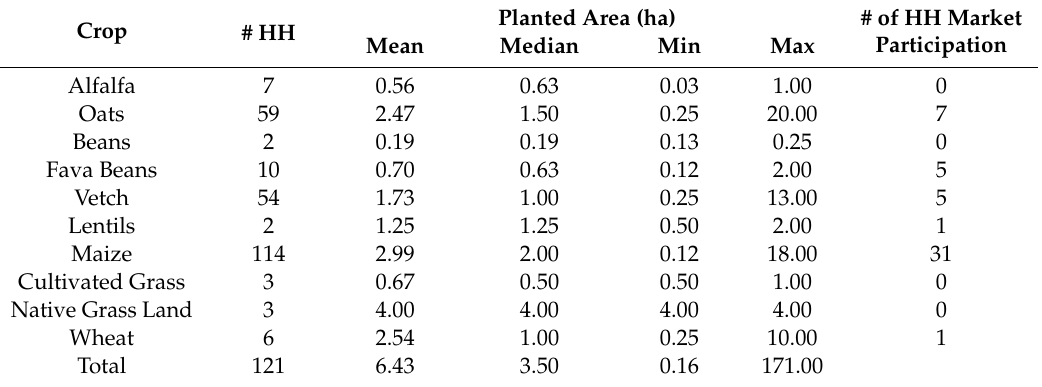
Table 3. Cropping system characteristics for primary, secondary and tertiary crops in 2018 ( N = 121 ). Planted Area Crop # HH